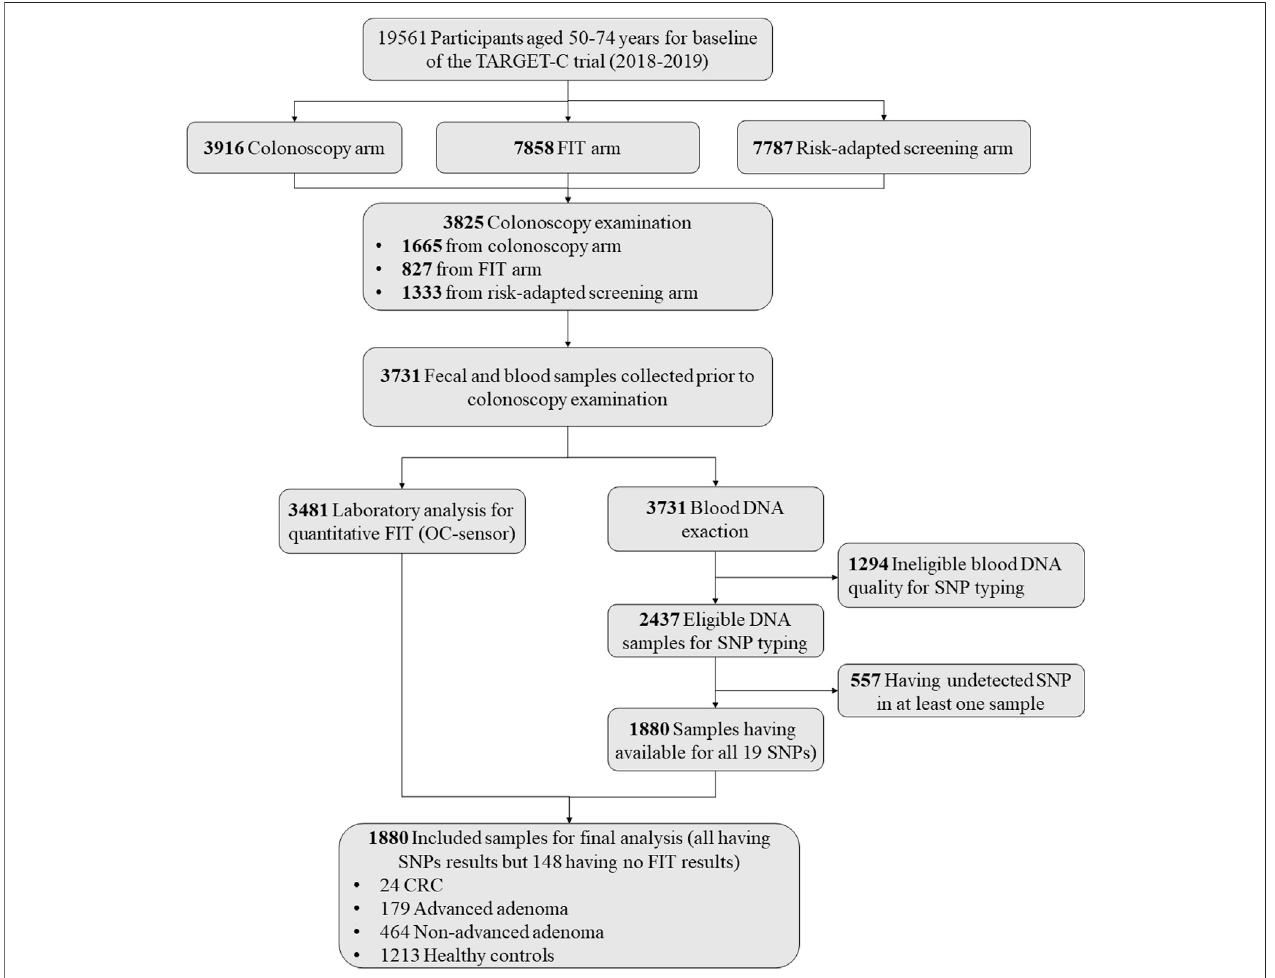
FIGURE 1 | Sample selection scheme for the present